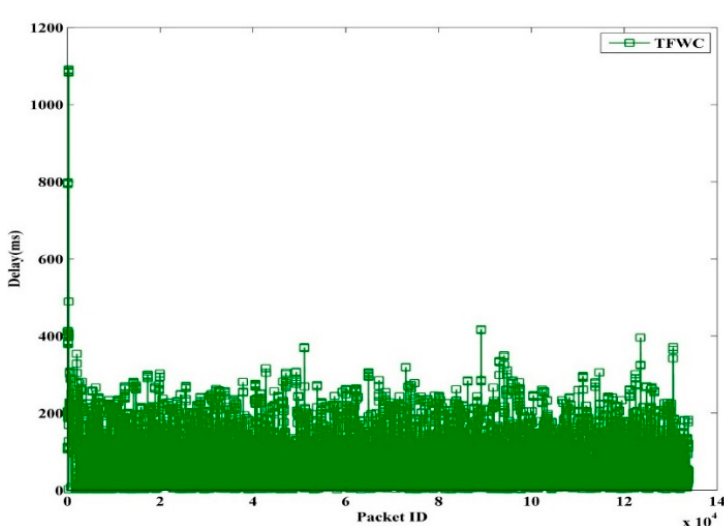
Figure 13. TFRC Packet Delay.